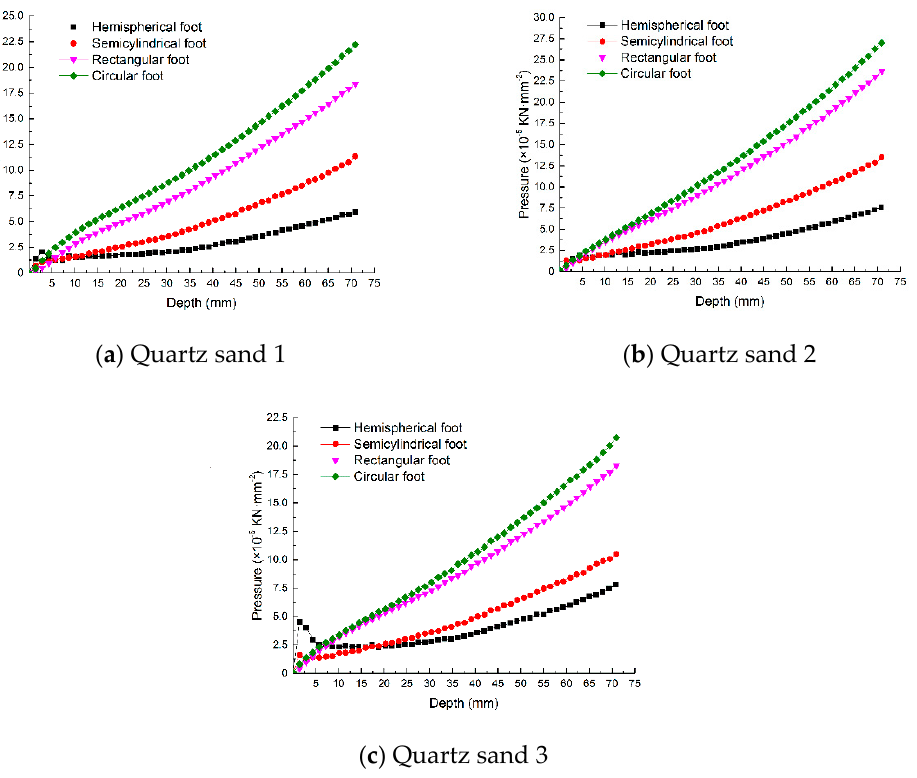
Figure 8. Comparisons of pressures for different feet.